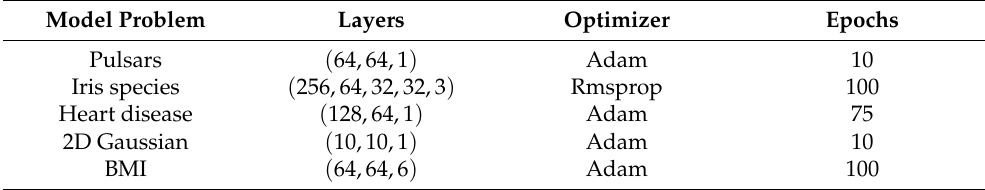
Table 4. The NN architecture used for each model problem. We only use fully connected layers. Model